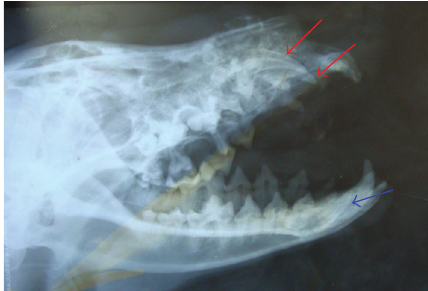
Figure 2: Laterolateral (oblique) head radiography of a maned wolf showing two unerupted maxillary canine teeth (the red arrow) and an unerupted right mandibular canine tooth (the blue arrow).